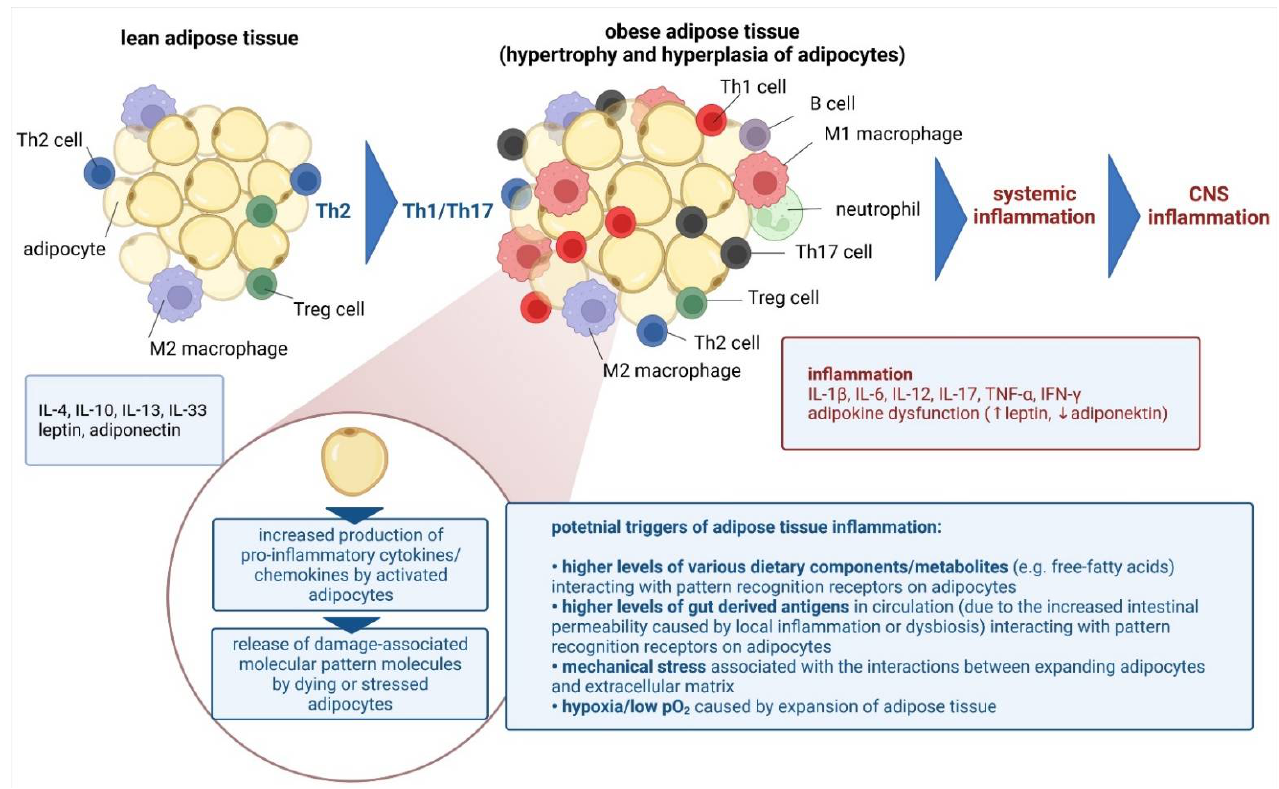
Figure 1. Chronic low-grade systemic inflammation in obesity resulting in the central nervous system inflammation [own drawing]. Abbreviations: CNS—central nervous system; IL—interleukin; IFN—interferon; Th—T helper; TNF—tumor necrosis factor.